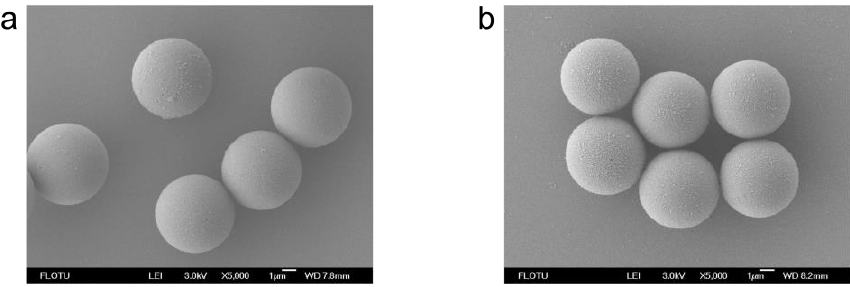
Figure 6. The SEM images of MIL − 101 − Ppa@SiO 2 before ( a ) and after tests ( b ).